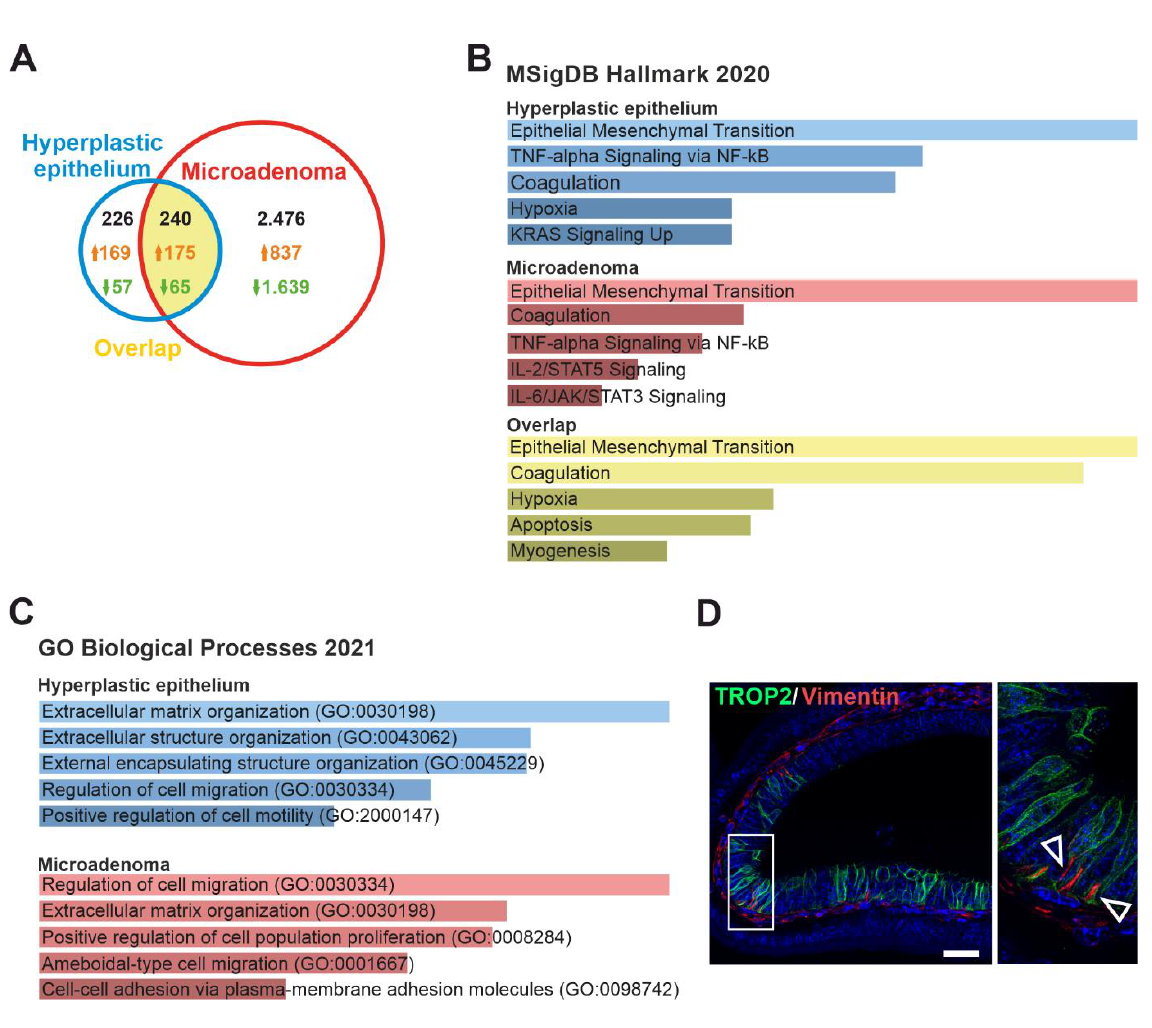
Figure 5. Analysis of gene expression profiles of Trop2 + tumor cells isolated from Apc-deficient neoplasia developed in two mouse models of Apc gene inactivation. ( A ) Venn diagram indicating the number of genes differentially expressed in Trop2-positive cells (compared to Trop2-negative cells) isolated from the hyperplastic epithelium of Ki67-RFP Apc cKO/cKO VillinCreERT2 mice or microadenomas of Rosa26-tdTomato Apc cKO/cKO Lgr5-EGFP-CreERT2 mice 7 days or 6 weeks after Apc inactivation, respectively. Significance criterion: |log 2 FC| > 1; adjusted p -value < 0.01. The genes are listed in Supplementary Tables S5 – S7. Differentially expressed genes were further analyzed using the MSigDB Hallmark 2020 ( B ) and GO Biological Processes 2021 ( C ) gene set collections. The adjusted p - value (calculated from Fisher’s exact test) was assigned to each category; five top categories with the adjusted p -value < 0.01 are shown. Note that the statistical significance was not reached for the overlap gene set using when the GO Biological Processes 2021 database was used. The coloring and length of the columns corresponds to the significance of each column in the graph — the longer column and lighter color indicate higher significance. ( D ) Immunodetection of Trop2 and vimentin in microadenomas that developed in Apc cKO/cKO Lgr5-EGFP-CreERT2 mice 6 weeks after Apc inactivation; magnified image of the inset is on the right. Arrowheads point to Trop2-positive epithelial cells with accumulated vimentin. Specimens were counterstained with DAPI; scale bar: 50 μm.